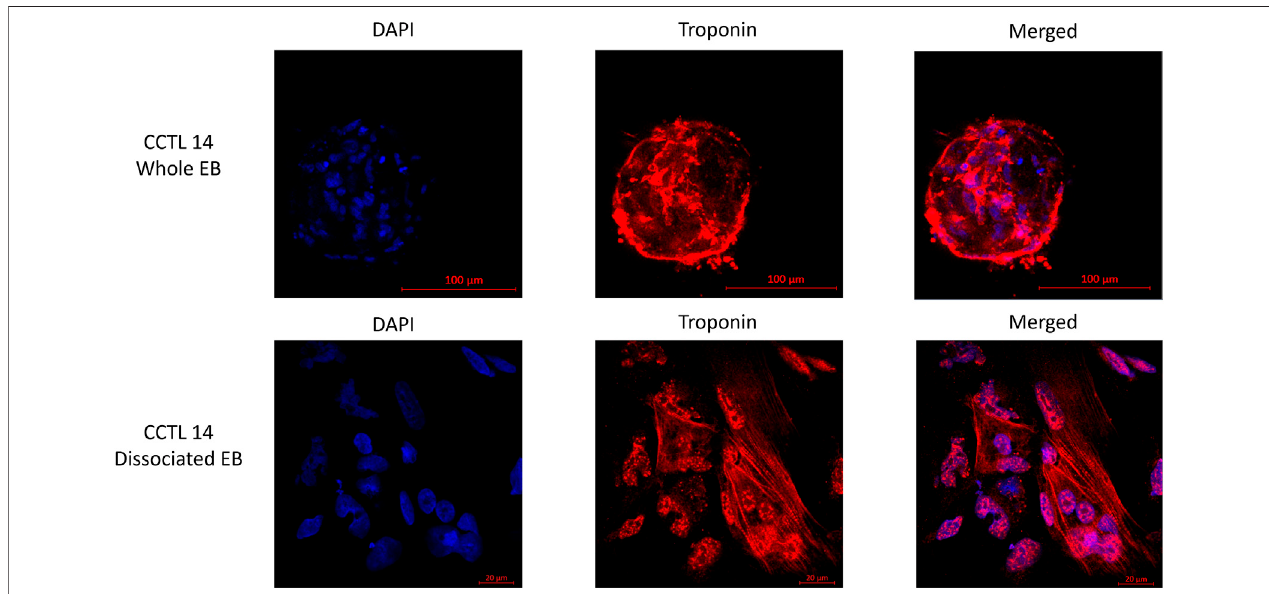
FIGURE 2 | Fluorescence staining of whole and dissociated CCTL14 EBs (cell cluster) illustrates the presence of matured cardiomyocytes identi fi ed by the presence of troponin T (red color); cells are localized with DAPI staining of the nucleus (blue